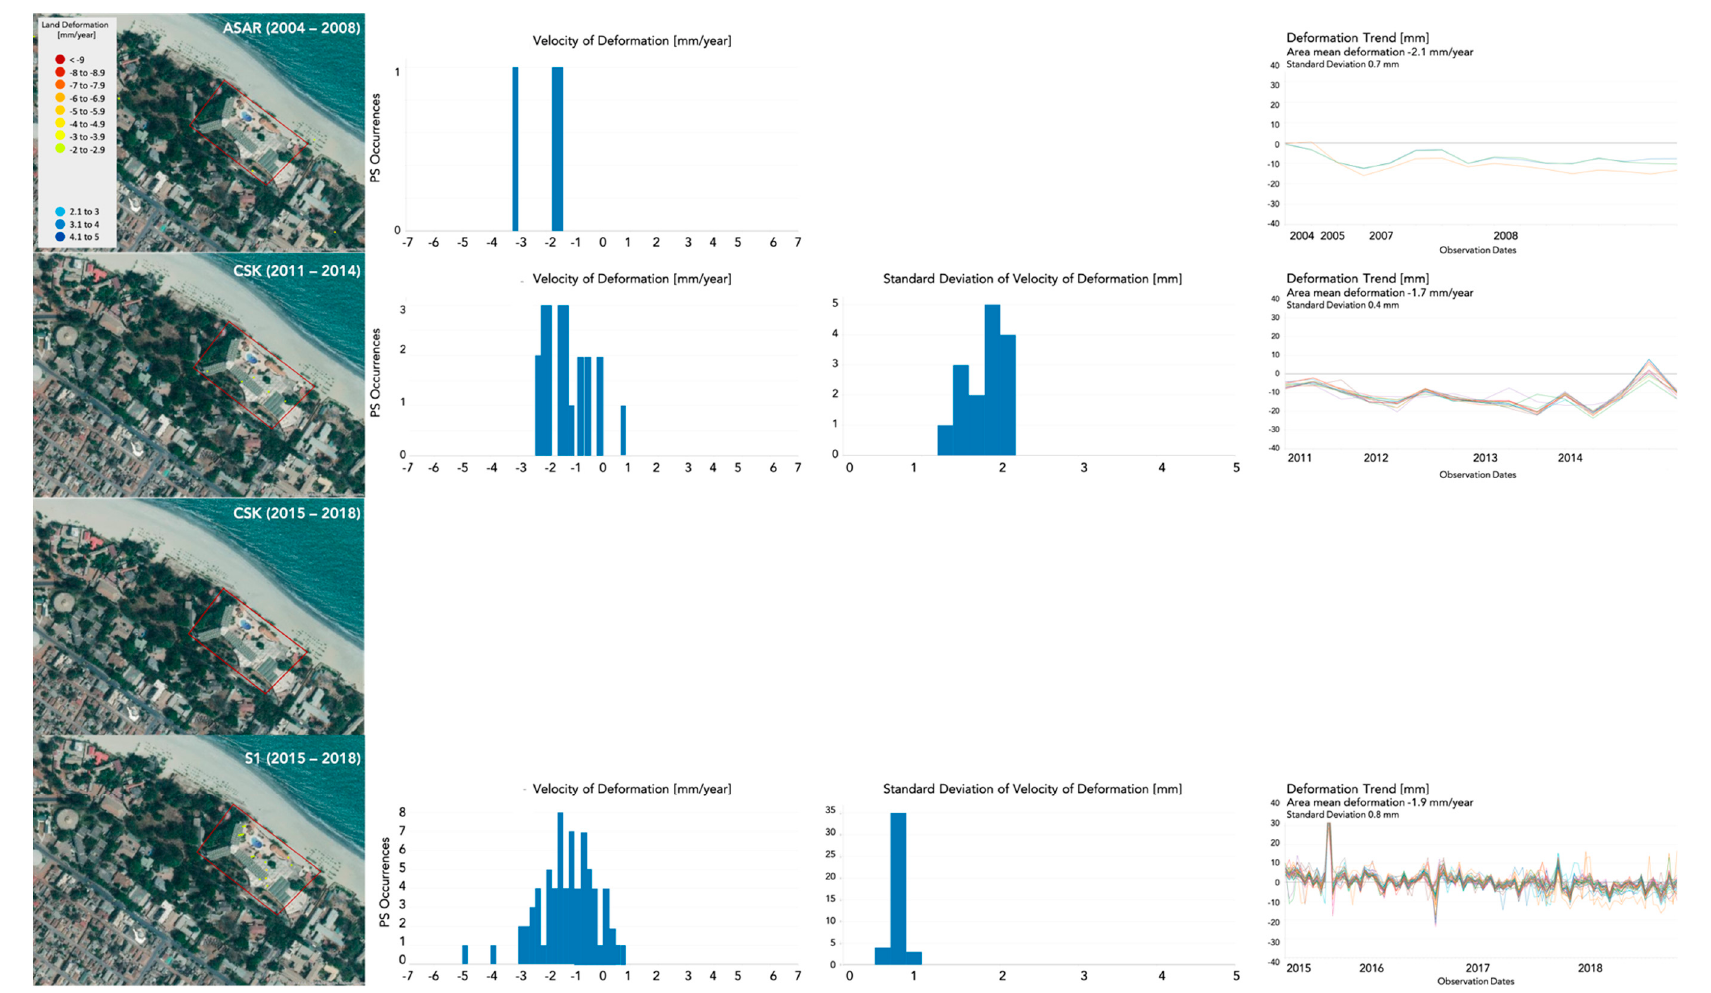
F igure 15. Banjul AOI 4. Figure 15. Banjul AOI